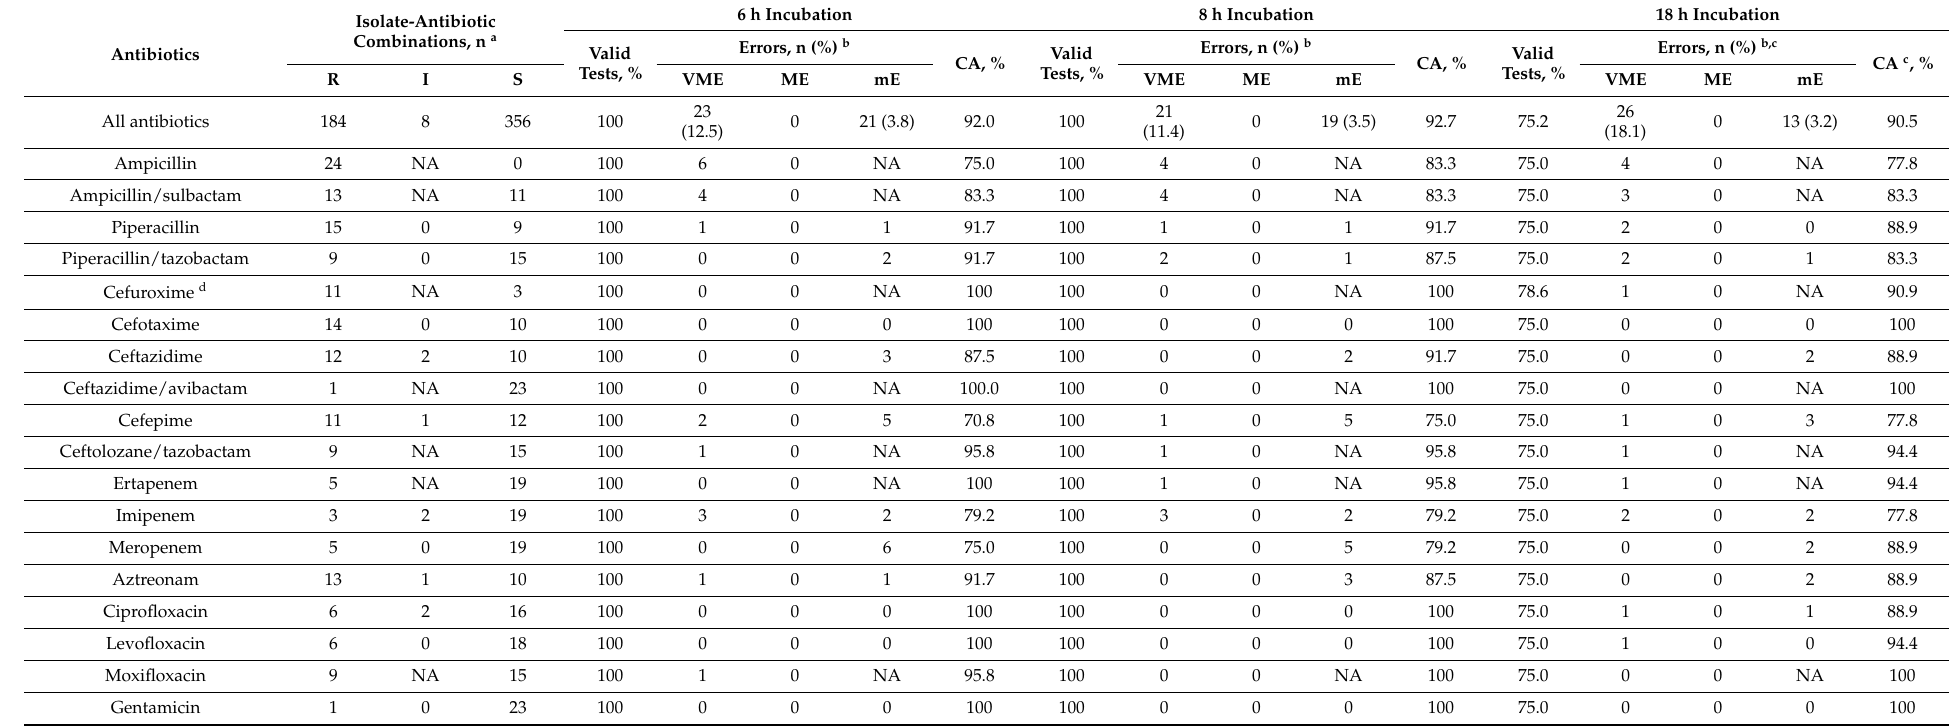
Table 1. Results of simultaneous DOT-MGA testing of multiple antibiotics vs. Enterobacterales , n =